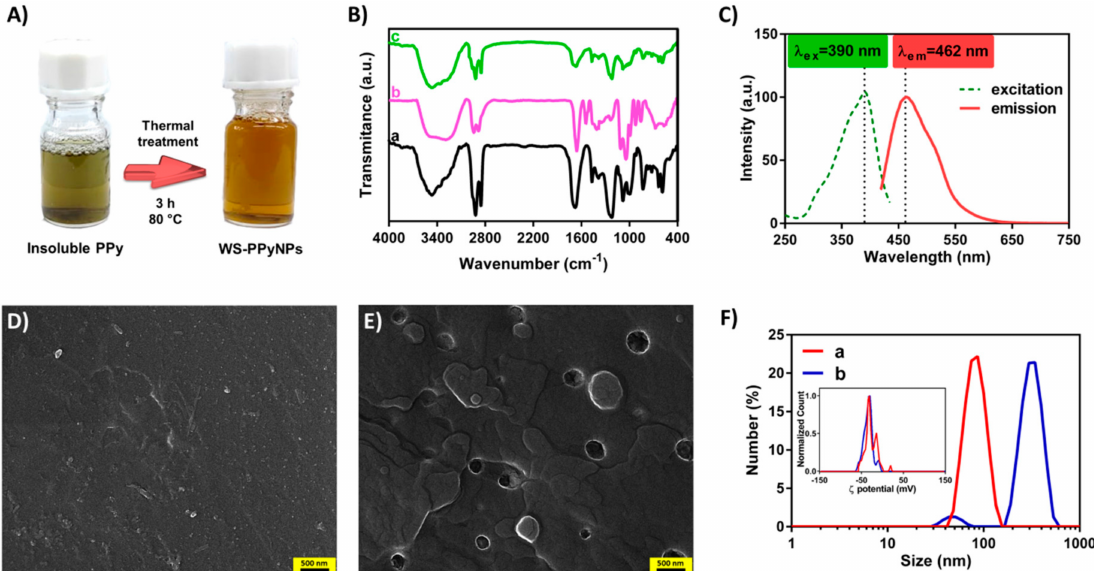
Figure 2. Assessment of the conversion of PPy to WS-PPyNPs. ( A ) The procedure for the conversion of insoluble PPy to WS-PPyNPs. ( B ) FT-IR spectra of (a) WS-PPyNPs, (b) INS, and (c) INS-loaded WS-PPyNPs. ( C ) Fluorescence excitation and emission spectra of 200-times diluted WS-PPyNPs. FESEM image of ( D ) WS-PPyNPs, and ( E ) INS-loaded WS-PPyNPs. ( F ) Size distribution and ζ potential (the inset) profiles of (a) WS-PPyNPs and (b) INS-loaded WS-PPyNPs obtained using DLS. Scale bar = 500